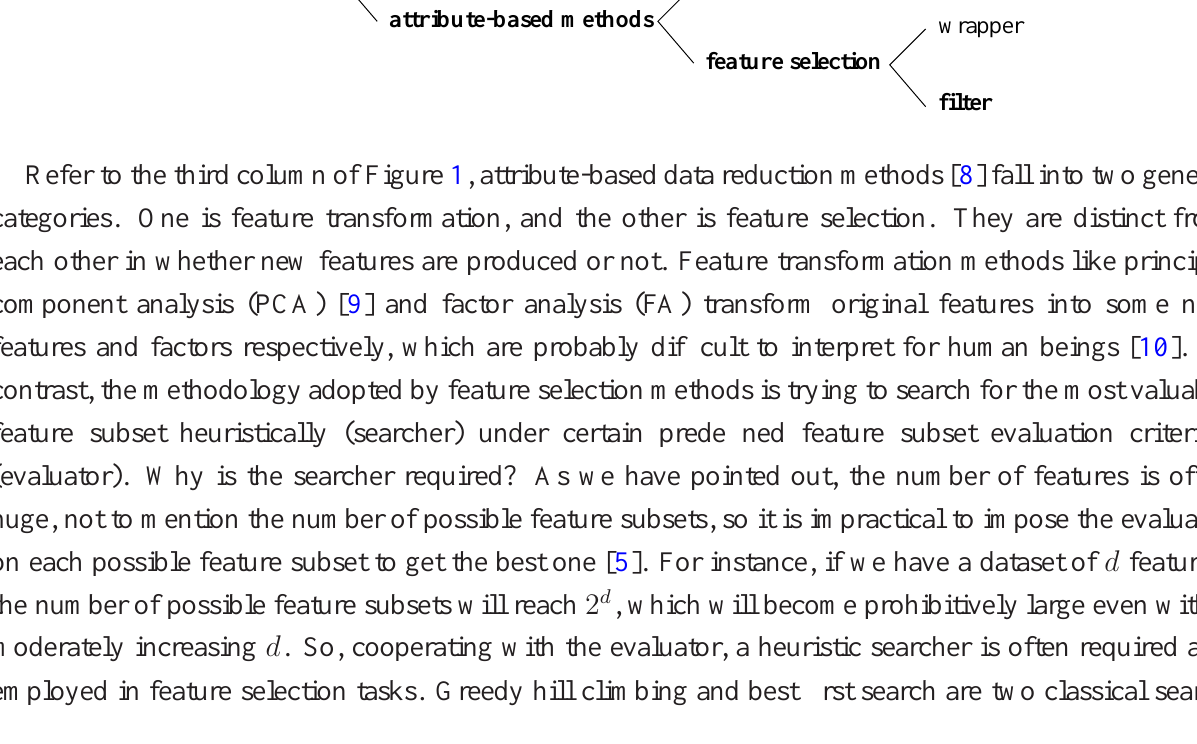
Figure 1. Categories of data reduction methods. The categories that our method belongs to are in boldface. instance-based methods data reduction attribute-based methods